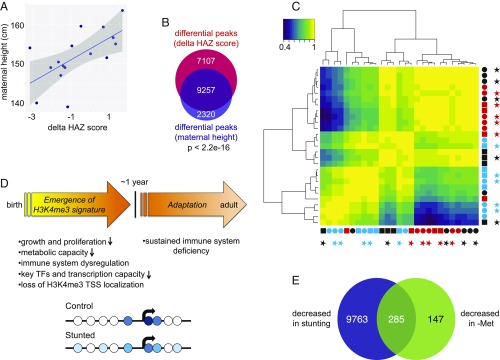
H3K4me3 pattern association with functionally relevant genes and changes over time. (A) Scatter plot showing ΔHAZ scores for children at 1 y of age versus the height of the child’s mother. (B) Comparison of H3K4me3 peaks in 1-y-olds correlated with ΔHAZ score versus the H3K4me3 peaks correlated with the height of the child’s mother. (C) Heat map showing the Pearson correlations between normalized H3K4me3 datasets from children at 18- and 52-wk and their mothers. The 18-wk datasets are labeled in red, 52-wk data in black, and maternal data in light blue. Circles indicate male and squares indicate female children; stunted children are denoted by stars. (D) Summary and working model of physiologic changes in cells from stunted children and H3K4me3 changes (Upper). Global H3K4me3 profile differences in control and stunted children at 1 y of age are depicted by the Lower schematic. Circles represent nucleosomes and the arrow represents the TSS of an average gene. Darker blue color signifies increased methylation level; white represents no H3K4 trimethylation. (E) Comparison of sets of genes with TSS-localized peaks decreased in human colon cancer cells minus methionine (green) (31) versus stunting at 1 y of age (blue; present study).